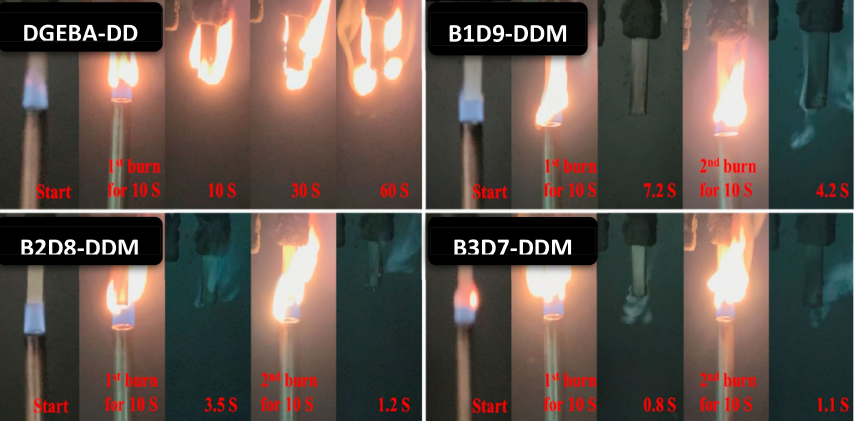
Figure 14. Digital photos of DGEBA-DDM, B1D9-DDM, B2D8-DDM, and B3D7-DDM for the UL-94 test. Reprinted with permission from J. Liu et al. [170] Copyright 2020